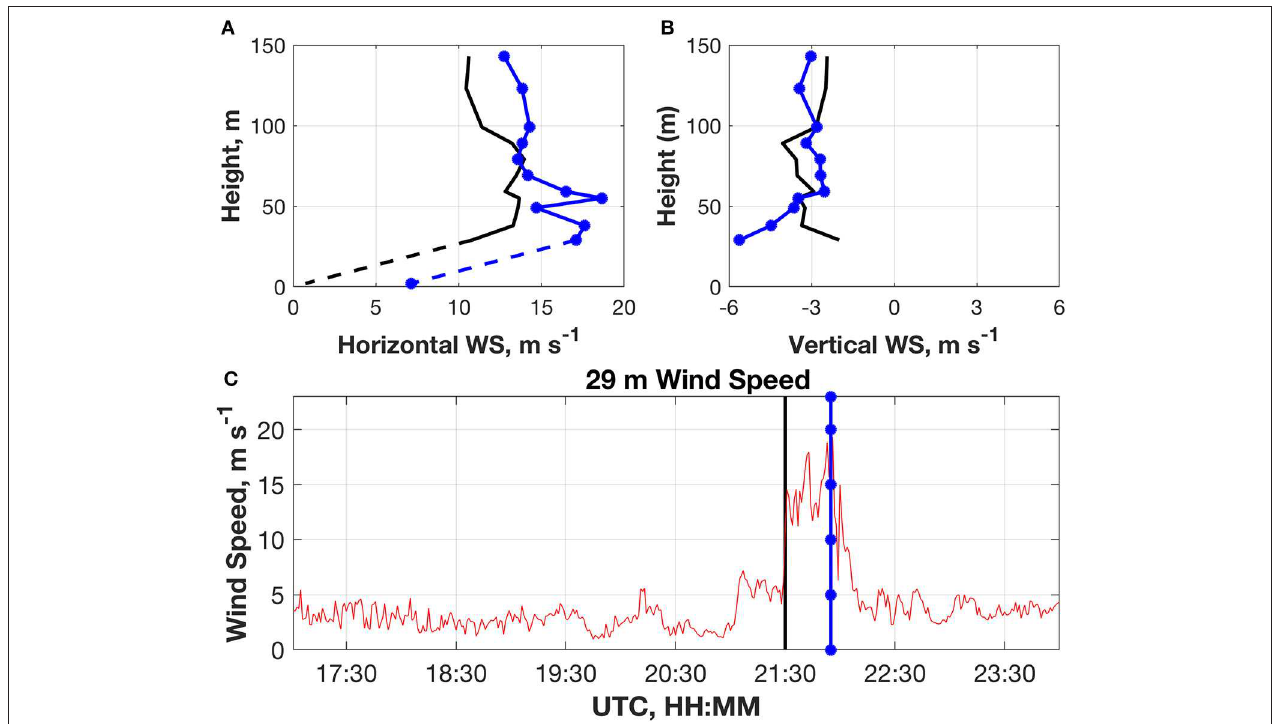
FIGURE 4 | Comparison of the 1min averaged (A) horizontal velocity profiles and (B) vertical velocity profiles at two different times (C) from the 3 July 2017 thunderstorm event. The profiles from earlier in the outflow are drawn in black, while the profiles from later in the outflow are drawn in blue.